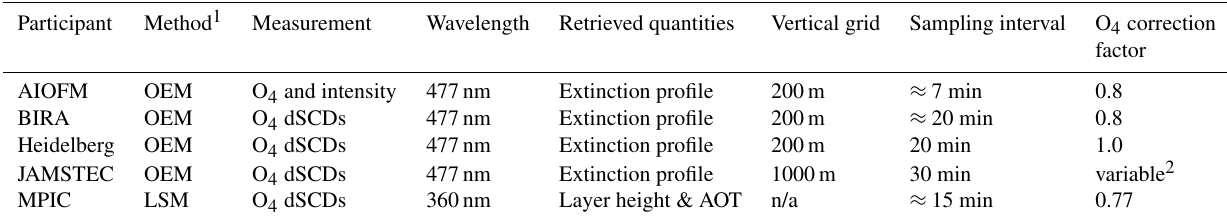
Table 1. Main features of the different retrieval algorithms. Participant Method 1